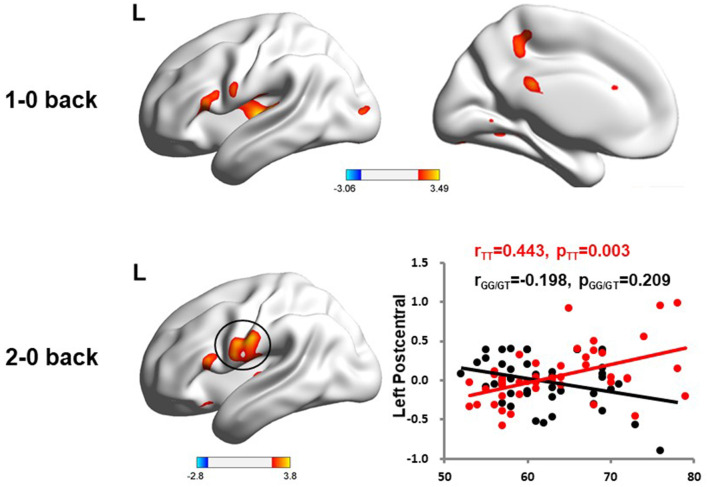
The significant interaction of age and rs405509 genotype on brain activity changes in condition 1-0 back and 2-0 back.